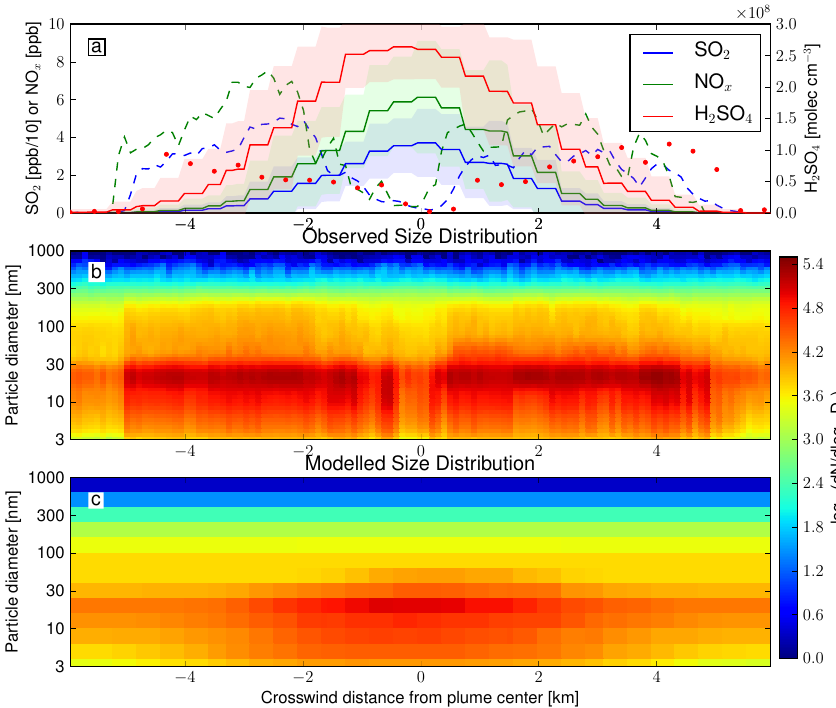
Fig. 5. Trace gas and aerosol concentrations along the first transect south of Conesville, about 24km from the power-plant. X-axes show flight track through cross-wind slice of plume. Model resolution is 400 × 400 × 40m. (a) Trace gas concentrations. Observed concentrations as dashed lines (SO 2 and NO x ) and dots (H 2 SO 4 ), model results as a solid line. Shaded area indicates one standard deviation of the model results, due to turbulent fluctuations. (b) Observed aerosol number size distribution. (c) Modeled aerosol number size distribution.